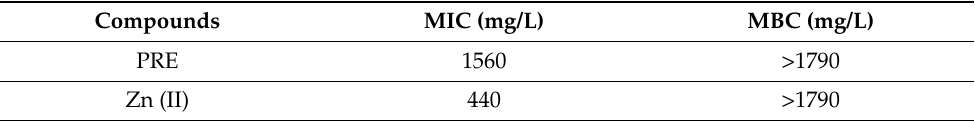
Table 1. Minimum inhibitory concentrations (MICs) and minimum bactericidal concentrations (MBCs) values of PRE (mg/L) and Zn (II) (mg/L) against M. luteus in broth suspensions. Presented data are the result of three independent